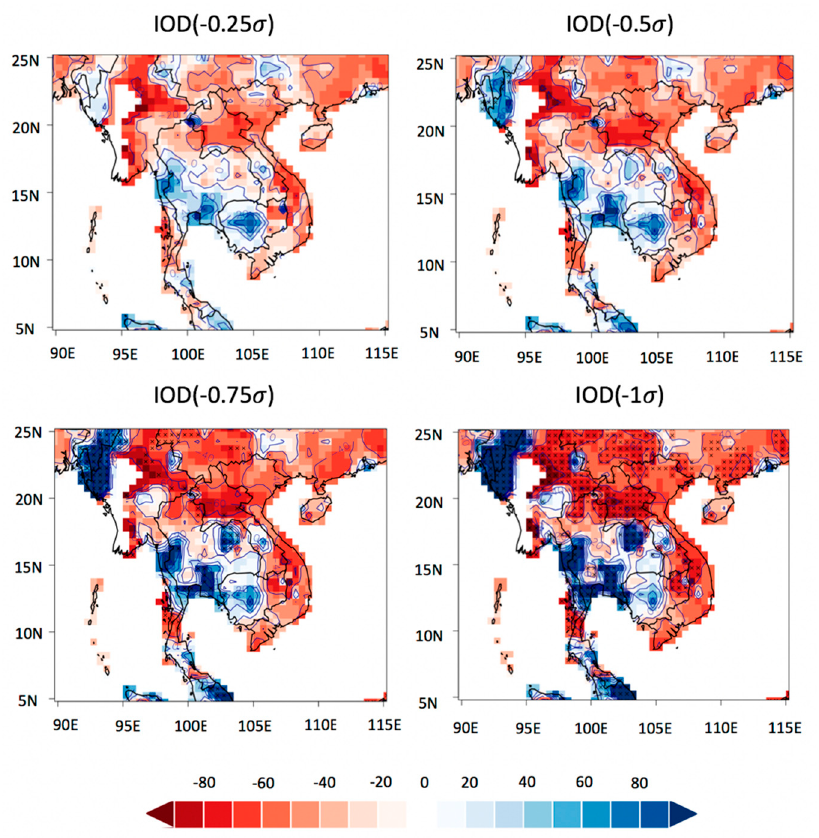
Figure 5. As Figure 4, but for a decrease in IOD in the tropical Indian Ocean.